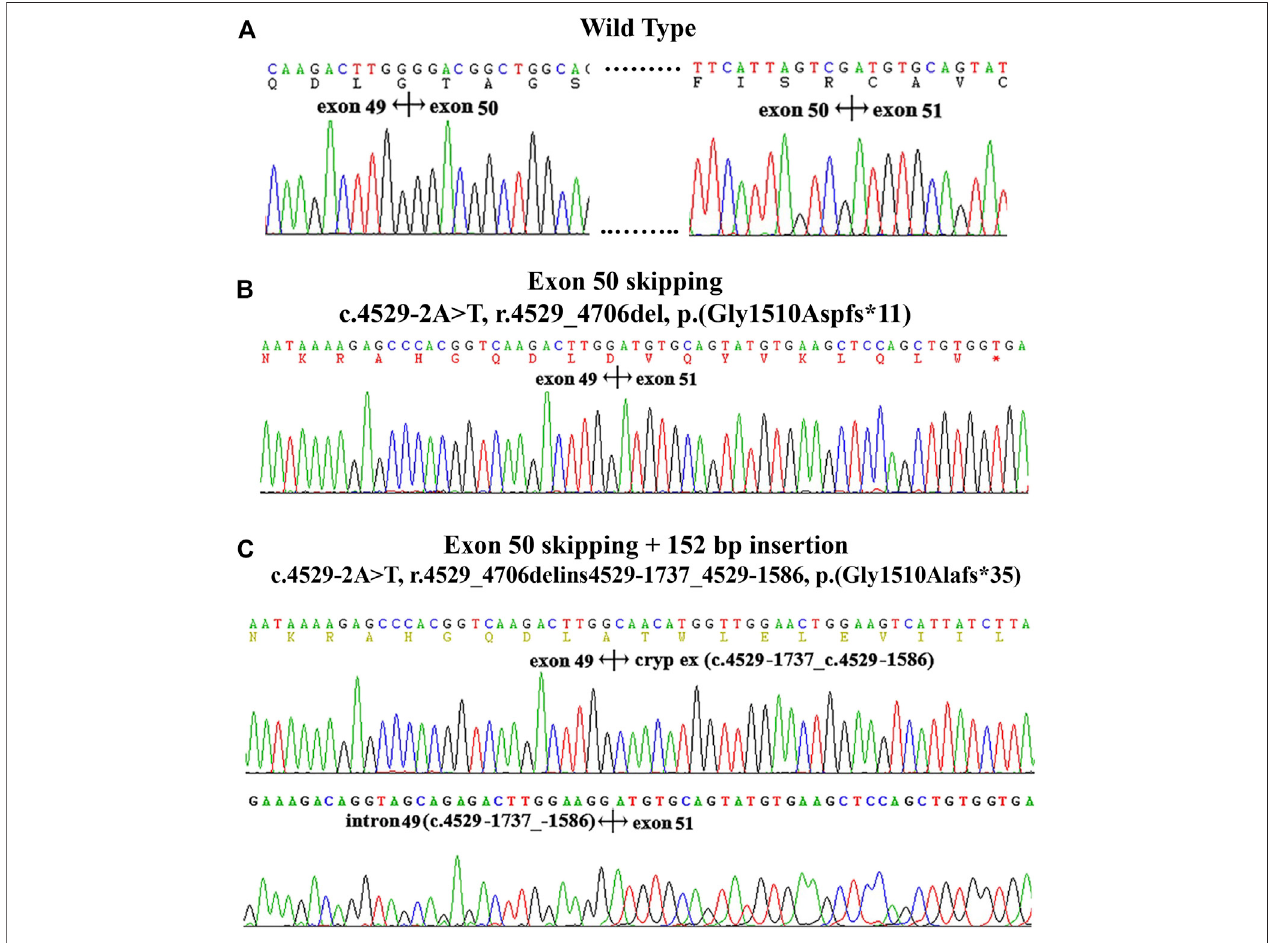
FIGURE 3 | cDNA sequencing results and electropherogram of kidney tissues from patients in family X3. (A) : the wild type. (B) : the skipping of exon 50. (C) the skipping of exon 50 and insertion of a 152 bp fragment from a cryptic exon of intron 49 (c.4529-1737_529-1586).